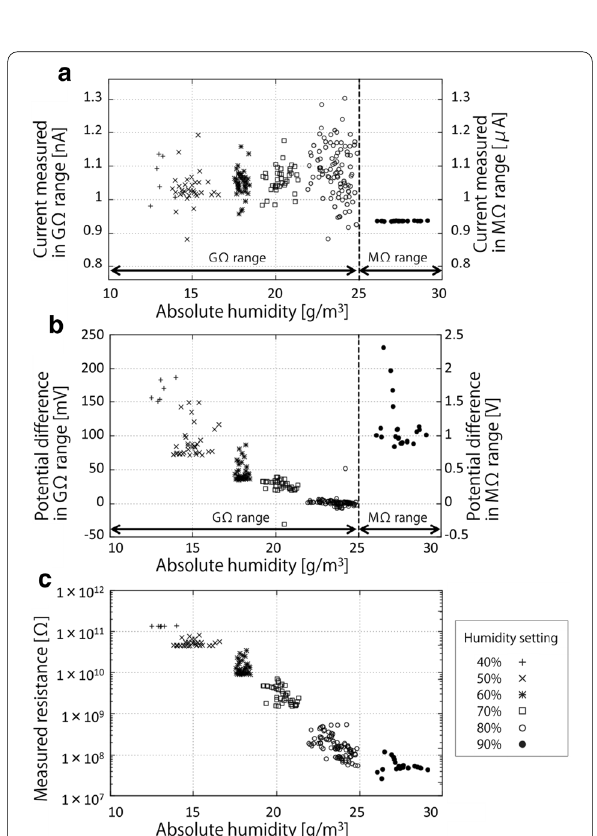
Fig. 8 Current, potential difference, and resistance with respect to absolute humidity. a Current measured by ammeter and b measured potential difference between P 1 and P 2 as a function of the absolute humidity. c Measured resistance between C 1 and C 2 as a function of the absolute humidity in log scale. Measurements were repeated in six sequences of relative humidity (40%, 50%, 60%, 70%, 80%, and 90%) under constant temperature (30 °C), with the symbols indicating the measurement sequence. The injected current amount depended on the resistance measurement range (Table